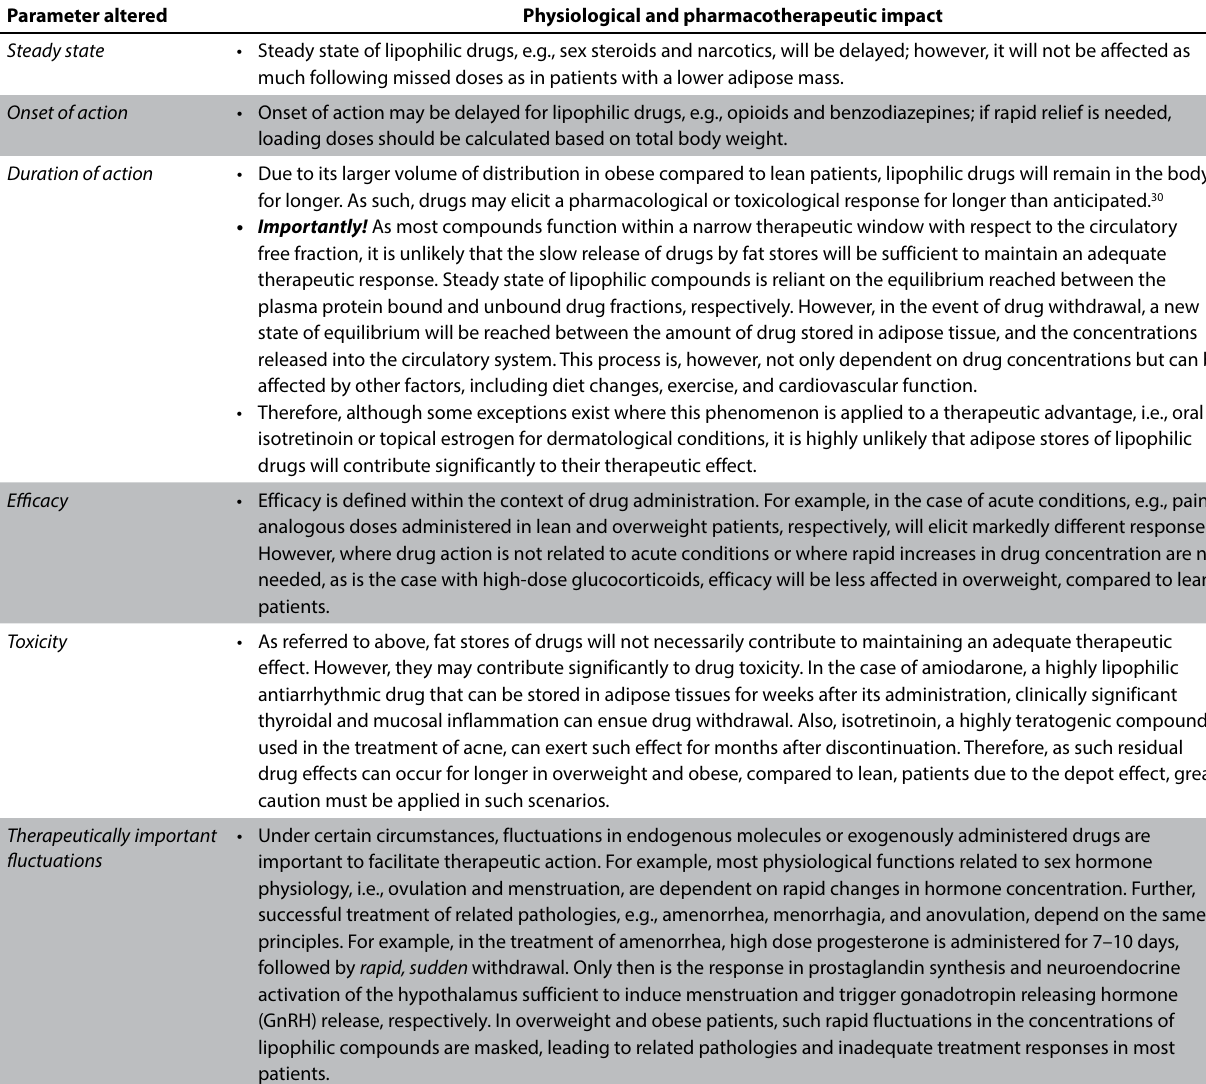
Table 3 - A summary of pharmacokinetic modifications in overweight and obese